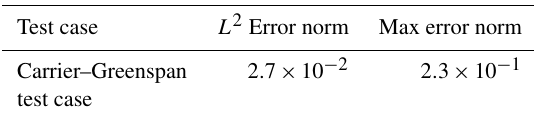
Table 4. L 2 error norm and maximum error norm between the MLMF and Monte Carlo CDFs for the Carrier–Greenspan test cases. Note that the error norms are unitless because the CDFs are